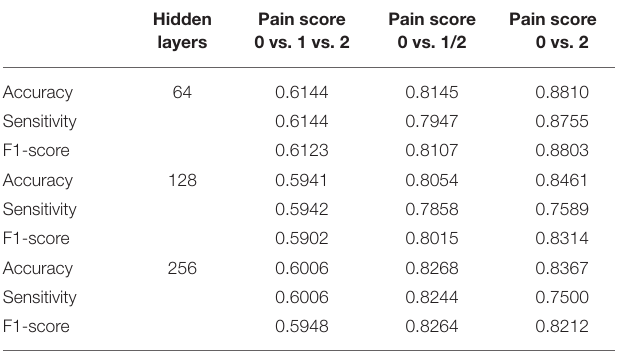
TABLE 3 | Performance of video-based pain classifiers with different numbers of hidden layers in bidirectional long short-term memory (BiLSTM)